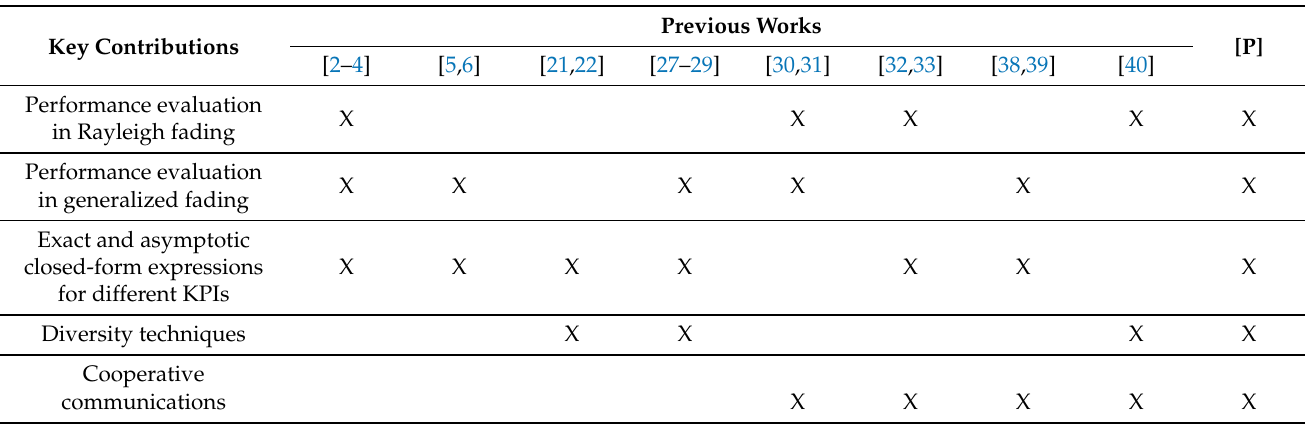
Table 1. Related work